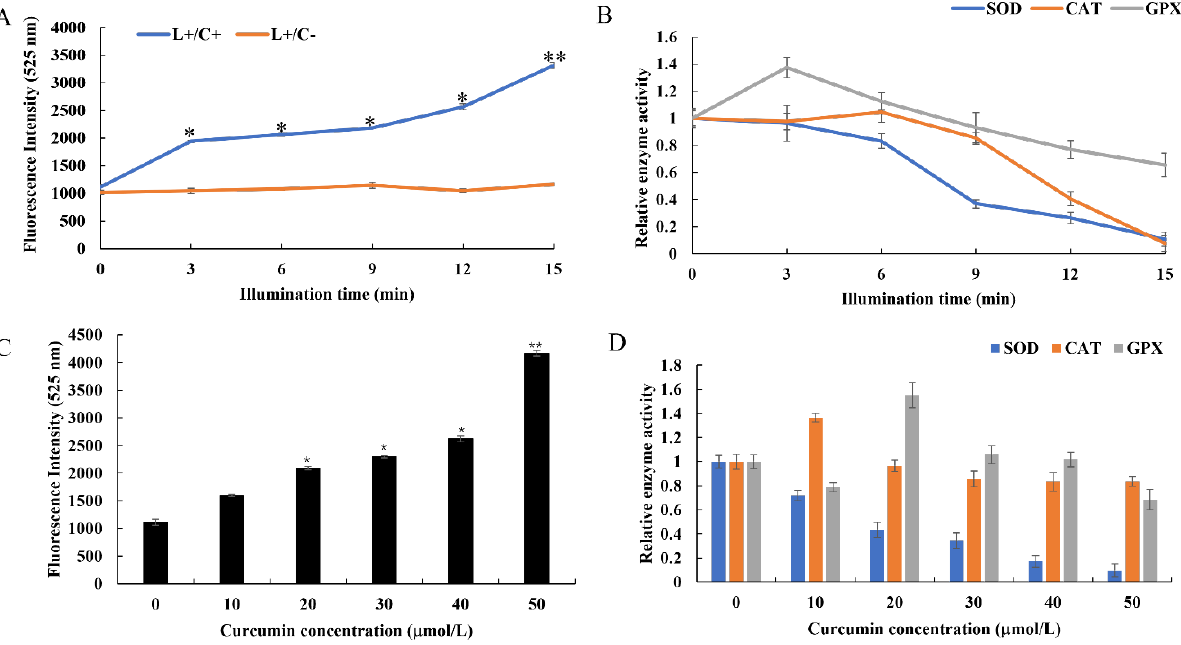
Figure 5. Effect of Cur-PDT treatment on redox state of B. subtilis in different conditions. Changes of ROS production under Cur-PDT treatment with different illumination time ( A ) and curcumin concentrations ( C ); Changes of antioxidant enzyme activity under Cur-PDT treatment with different illumination time ( B ) and curcumin concentrations ( D ). Asterisk indicates the significant differences (*, p < 0.05; **, p < 0.01).